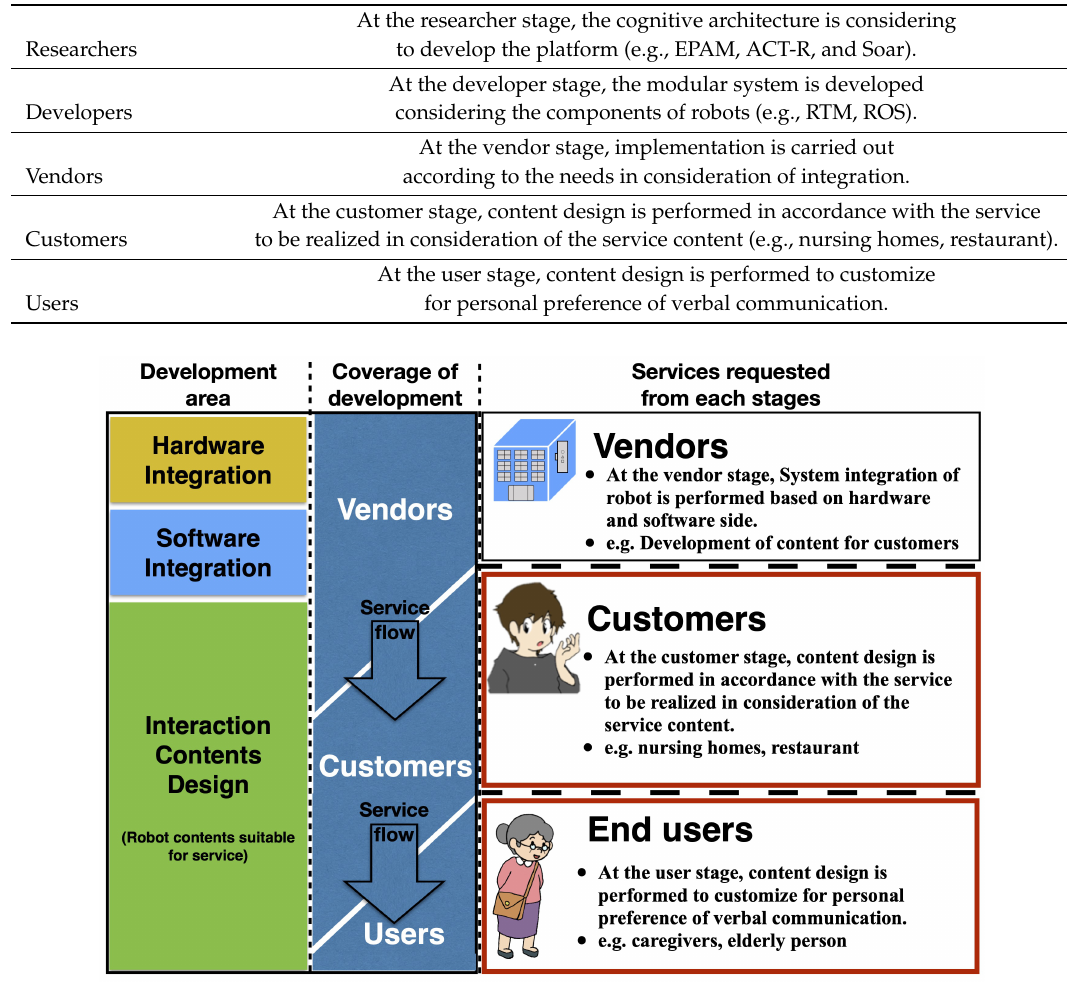
Figure 1. Robot partner development